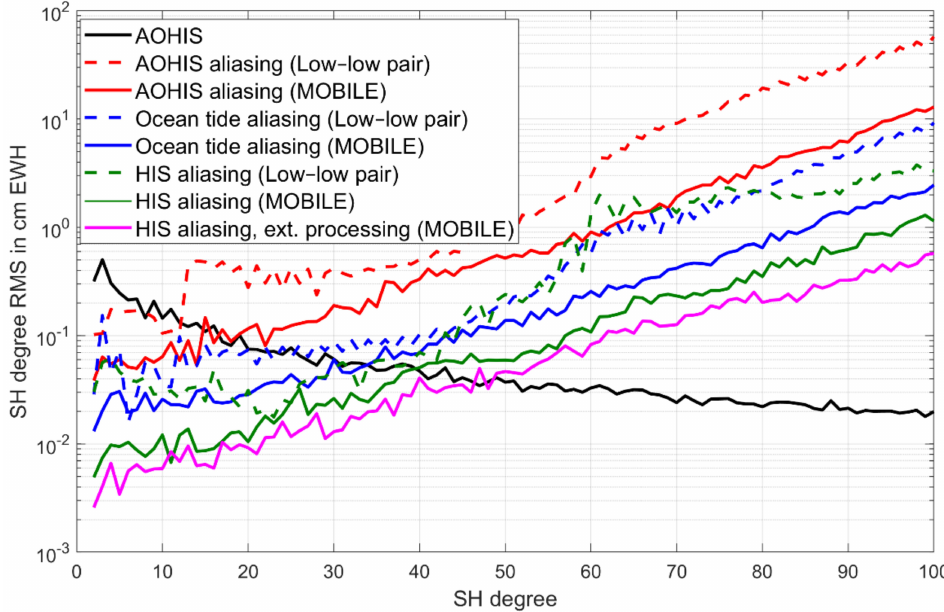
Figure 8. Degree (error) standard deviations after 1 month of full AOHIS signal (black), low–low pair formation (dashed curves), and MOBILE constellation (continuous curves), when including only AOHIS signals + instrument errors (red), ocean tide signals + instrument errors (blue), HIS signals + instrument errors (green), and HIS signals + instrument errors using the extended processing method